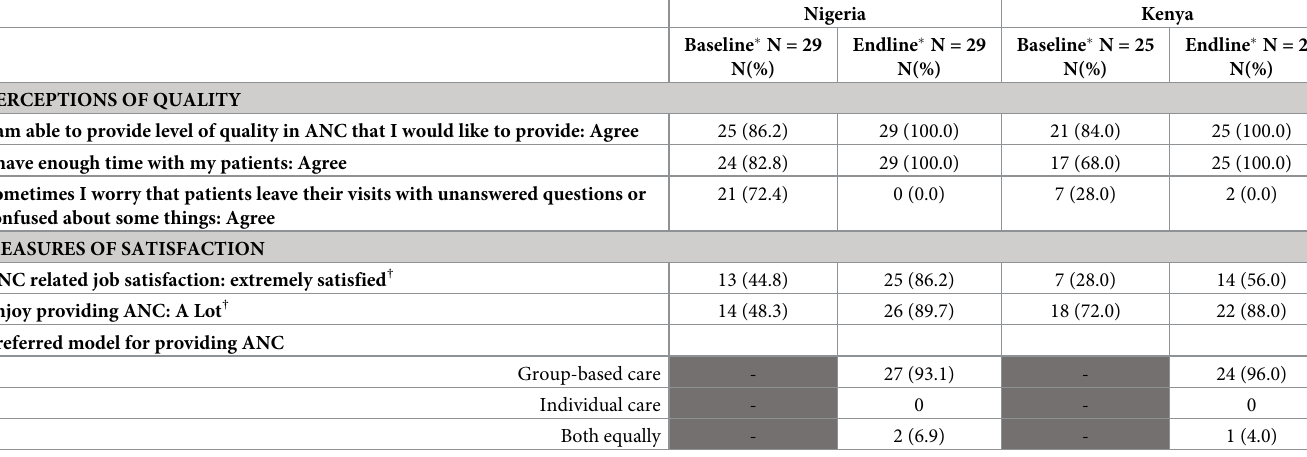
Table 5. G-ANC effect on provider perceptions of quality, satisfaction, and ANC model